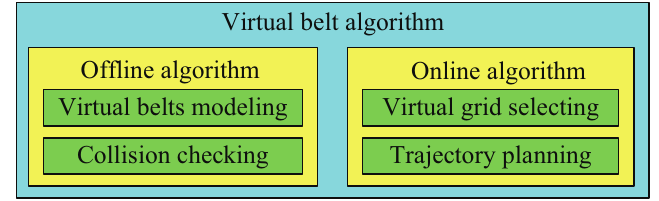
Figure 1. Structure of the VB algorithm.